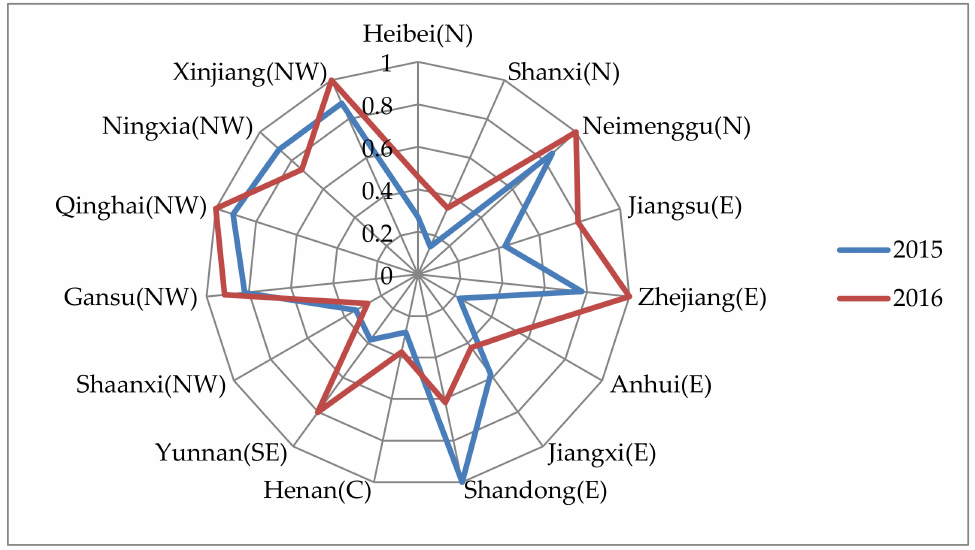
Figure 4. Photovoltaic power generation efficiency in various provinces of